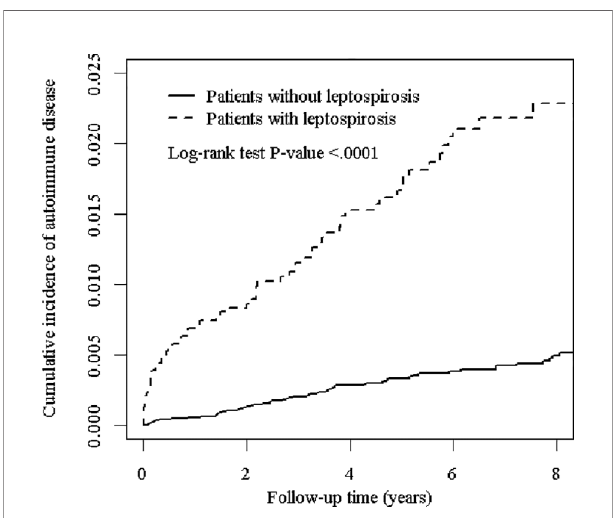
FIGURE 1 | The cumulative incidence of major autoimmune diseases for the patients with and without